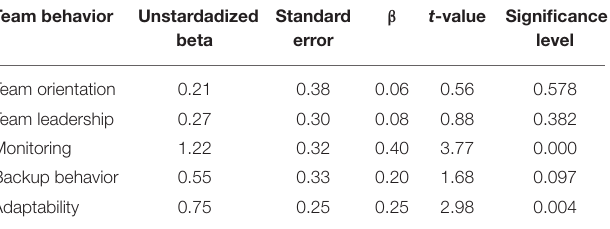
TABLE 3 | Unstandardized and standardized coefficient ( β ), standard error, t -values, and significance levels for decision-making behavior regressed upon team behavior.